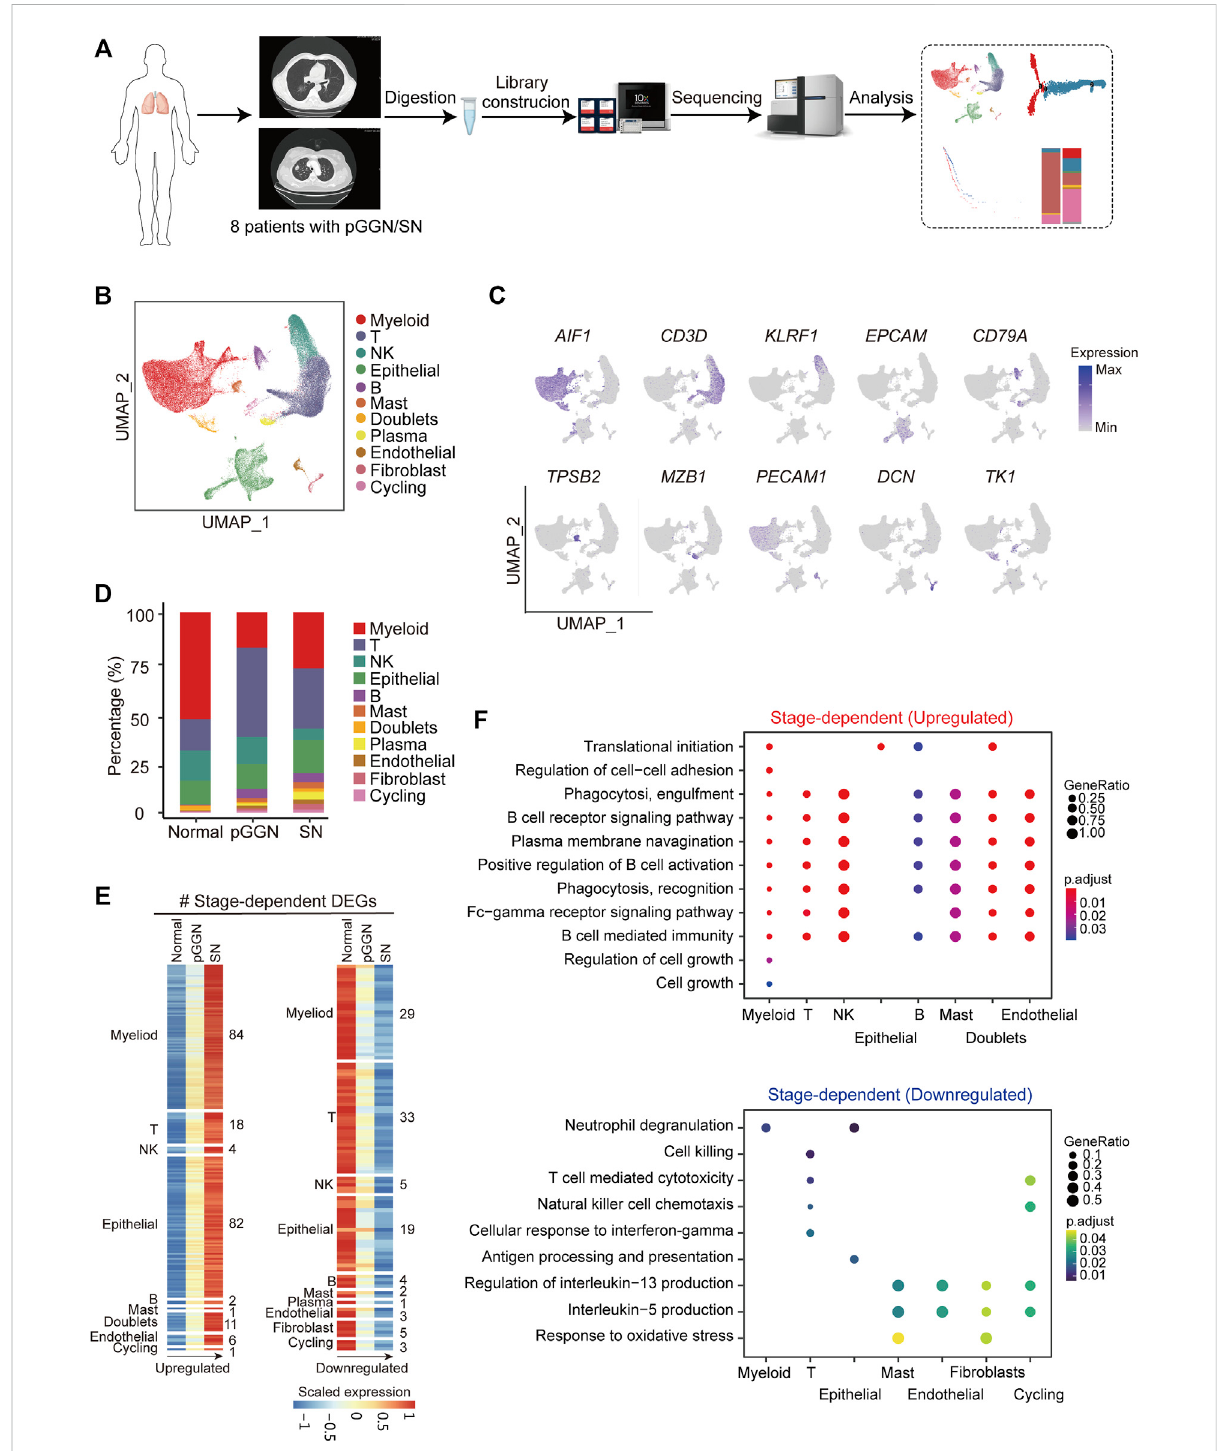
FIGURE 1 Single-cell transcriptomic pro fi ling of pure GGN and SN. (A) Schematic diagram of experimental fl ow. Single-cell RNA sequencing was applied to cells derived from 4 pure ground glass nodules (GGNs), 4 solid nodules (SNs) and 4 normal tissues. (B) Uniform manifold approximation and projection (UMAP) plot of 76,762 cells from 8 tumors and 4 adjacent normal tissues, colored by 11 major cell types. (C) UMAP plot of canonical cell typemarkers,coloredbygene expression. (D) The proportion of major cell types amongdifferenttissue origins,coloredbythemajor cell types as shown in (B) . (E) The expression of stage-dependent upregulated (left) and downregulated (right) genes of each cell type. (F) Enriched GO terms ( p < 0.05) of upregulated genes (upper) and downregulated gene (lower) of each cell type. The color indicates the adjusted p- value, and the size of dot indicates gene